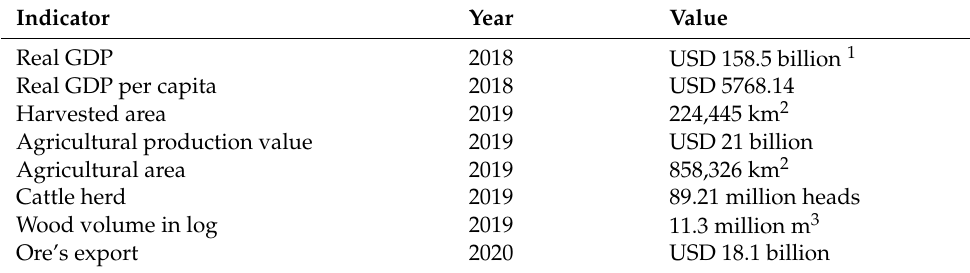
Table 2. Brazilian Amazon’s main economic indicators. Source: [21].